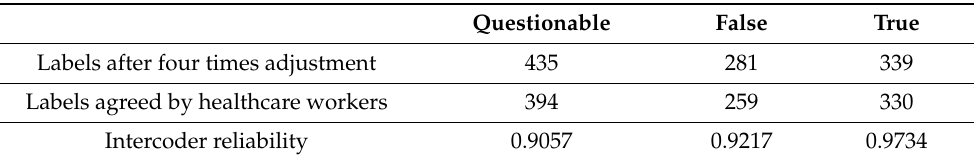
Table 3. Intercoder reliability between labels after four times adjustment and labels annotated by healthcare workers.